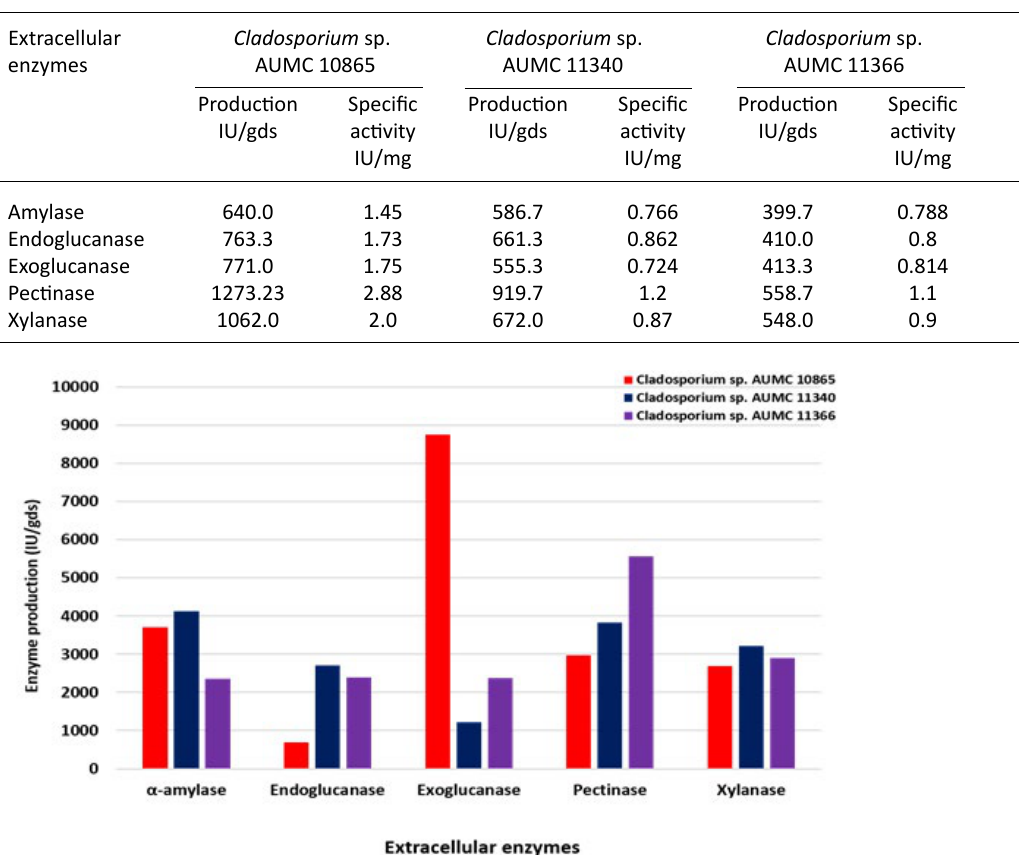
Fig. 3. Enzymes production (IU/gds) by Cladosporium isolates AUMC 10865, AUMC 11340 and AUMC 11366 at 30°C in